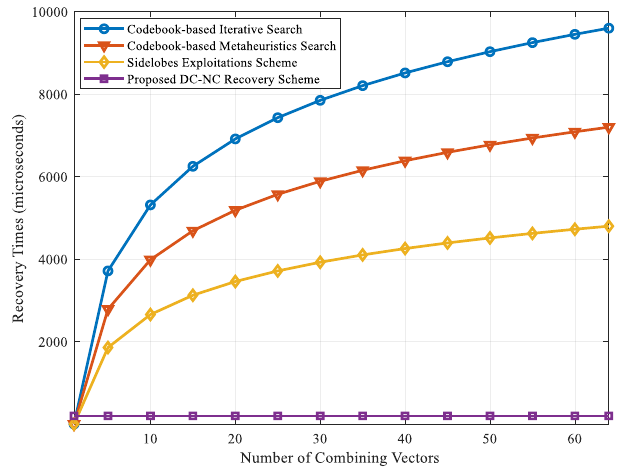
Figure 4. Recovery times at different numbers of combining vectors.